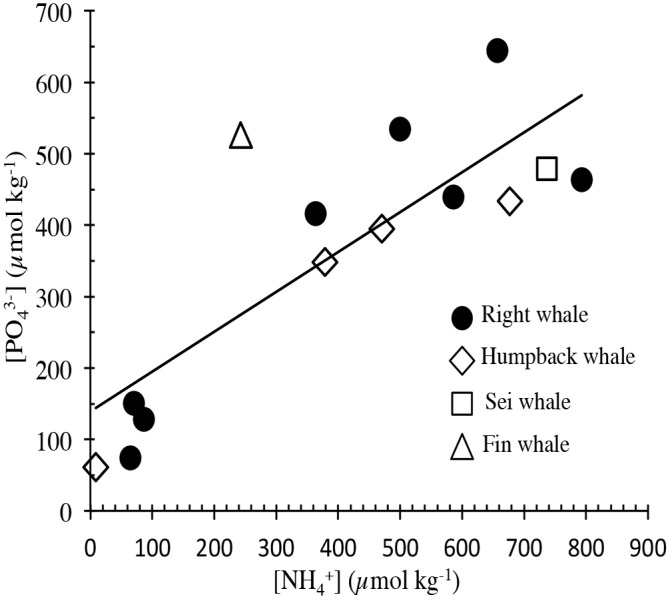
Regression analysis of dissolved NH4+ and PO43- concentrations in whale feces filtrate at initial sampling.For all species combined, R2 = 0.73.